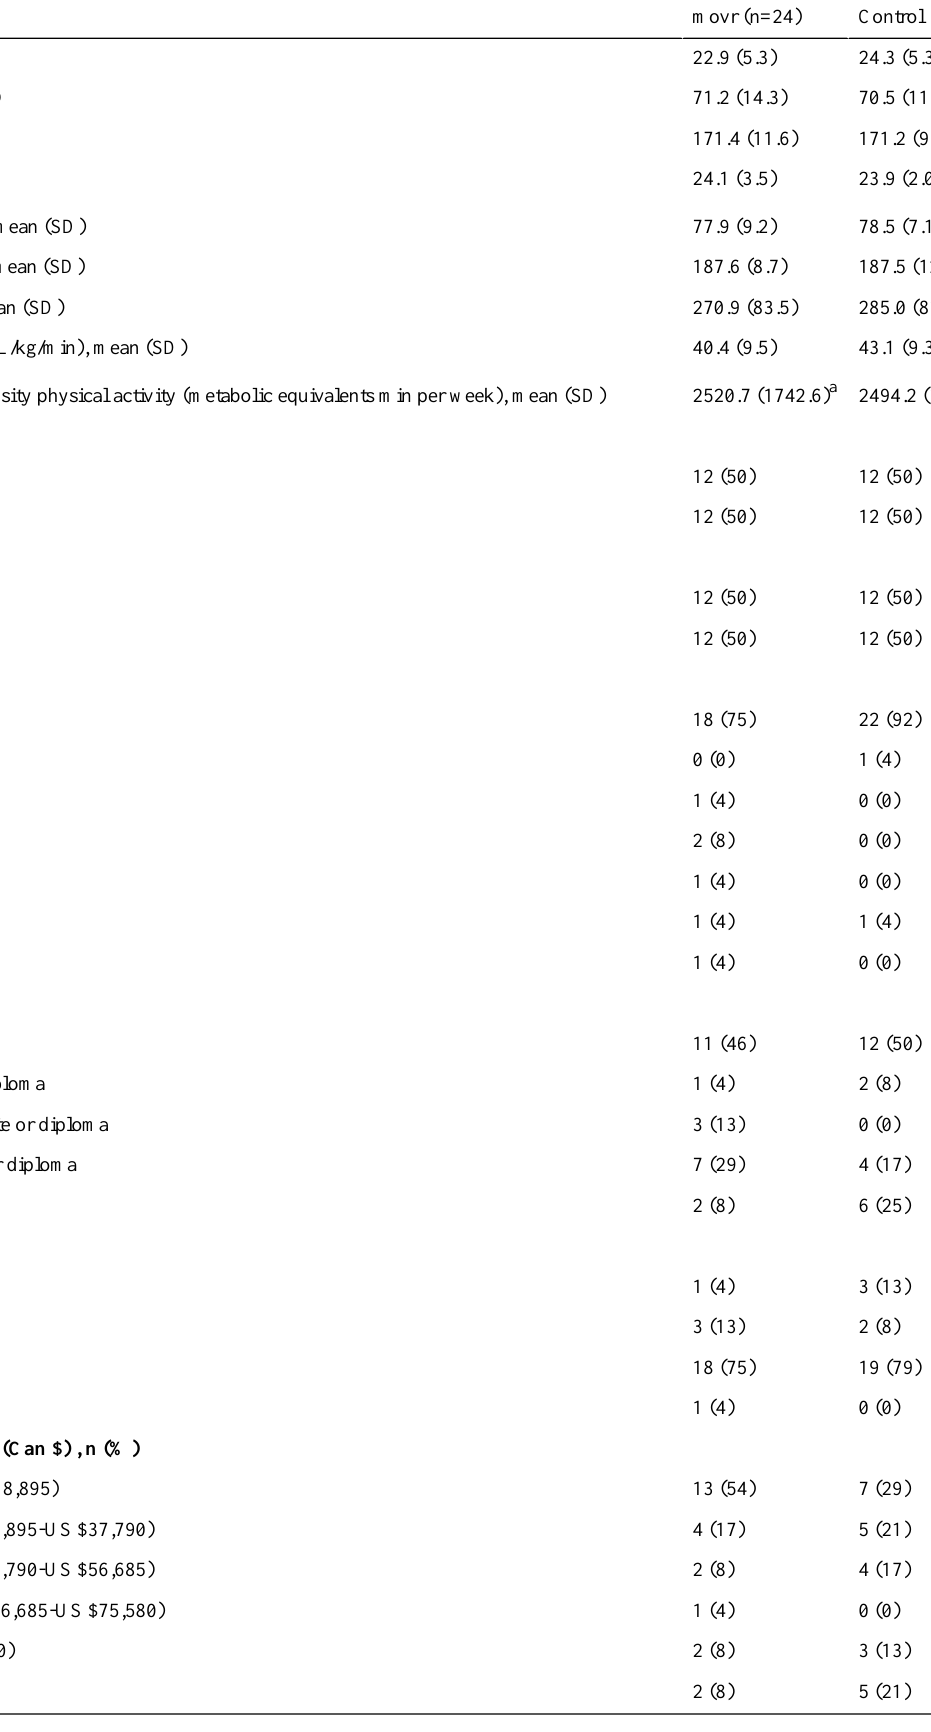
Table 1. Participant baseline